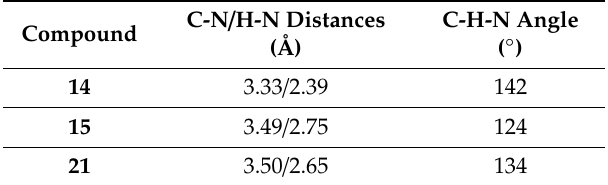
Table 1. Weak H-bonding interactions in the crystal lattice between the carborane C-H groups and the pyridine N atoms of the neighboring molecules.